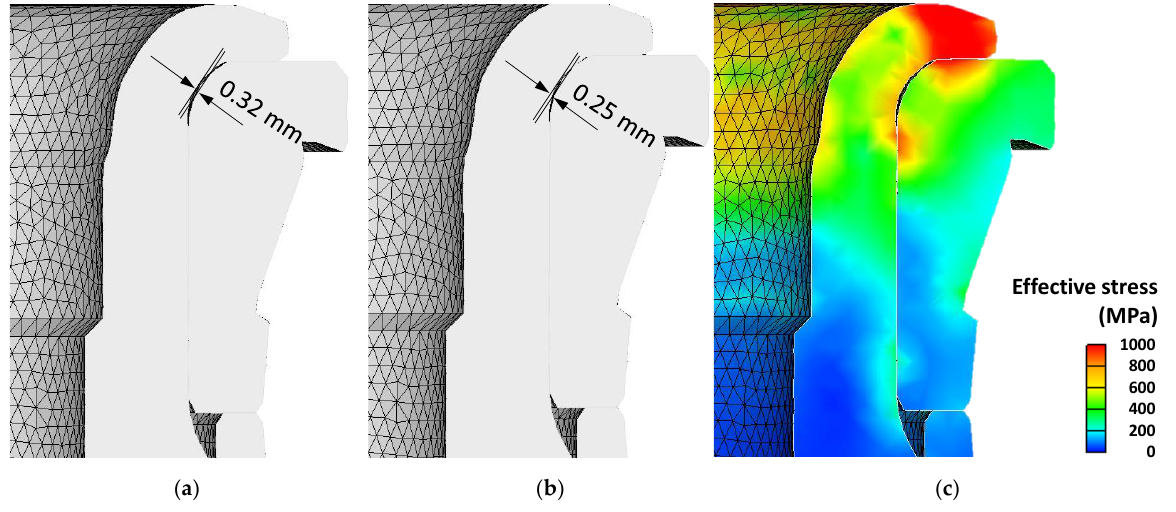
Figure 8. Predicted shape of DPTR WBU with an emphasis on the cavity and residual effective stress: ( a ) force-prescribed forming roller; ( b ) velocity-prescribed forming roller; ( c ) residual stress when using a force-prescribed forming roller.